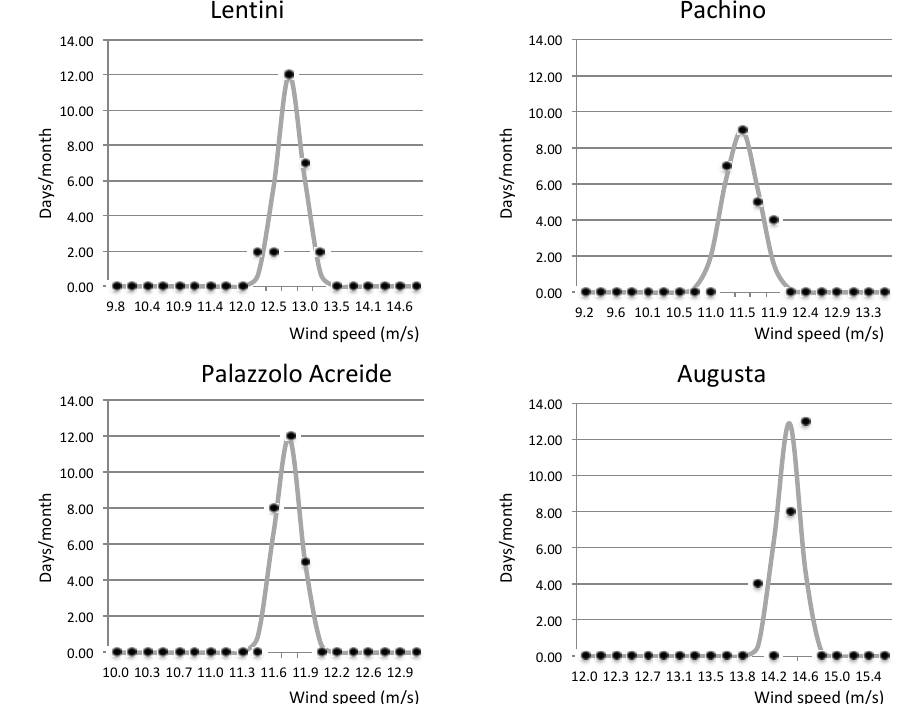
Figure 2. Calculated windiness 80 m above the ground—Province of Siracusa.